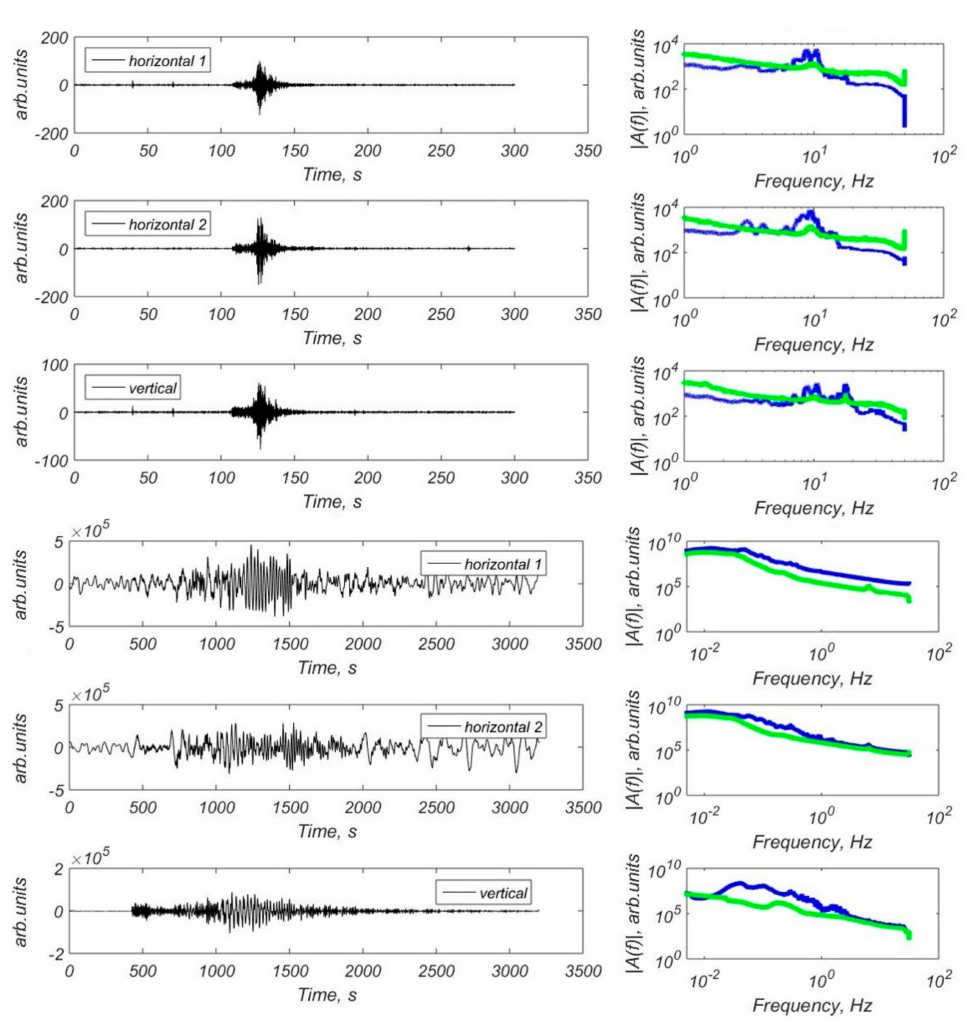
Figure 16. Examples of waveforms and Fourier spectra recorded by OBSs in the Laptev Sea (modified after [20]). Three upper panels: waveforms (bandpass filter 2–45 Hz applied) and the FFT spectra of the local microearthquake with P-arrival at 11 November 201901:58:31 UTC, obtained by the three-component CME-4311 channels of the MPSSR station; Three lower panels: waveforms and FFT spectra of the earthquake with M = 7.1 that occurred in Alaska (30 November 2018 17:29:29 UTC) [38] obtained by the three-component CME-4111 channels of the GNS-C station. Blue line—the spectra of the earthquake, green line—the spectra of the seismic noise preceding P-wave